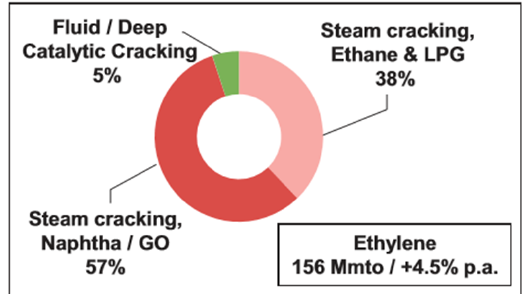
Figure 2. C 2 H 4 production methods using hydrocarbon feedstocks. Reproduced from [3]. 2014, WILEY-VCH Verlag GmbH & Co.